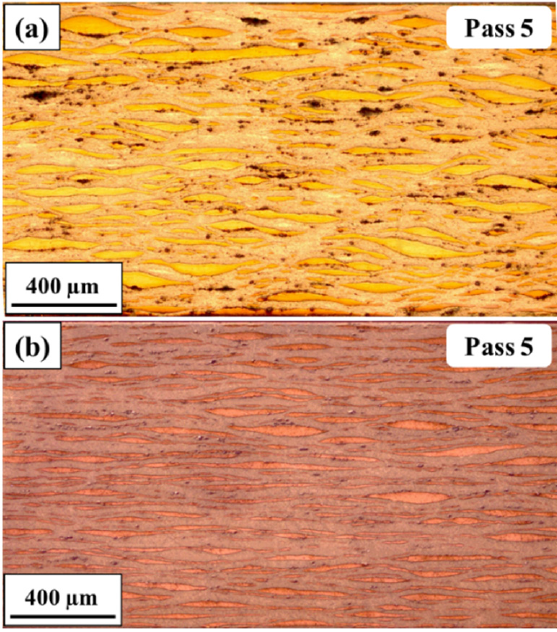
Figure 4. OM images of laminated composites at the fifth pass: ( a ) ARBed-Al/Cu/3wt%SiC, ( b ) CARBed-Al/Cu/3wt%SiC.